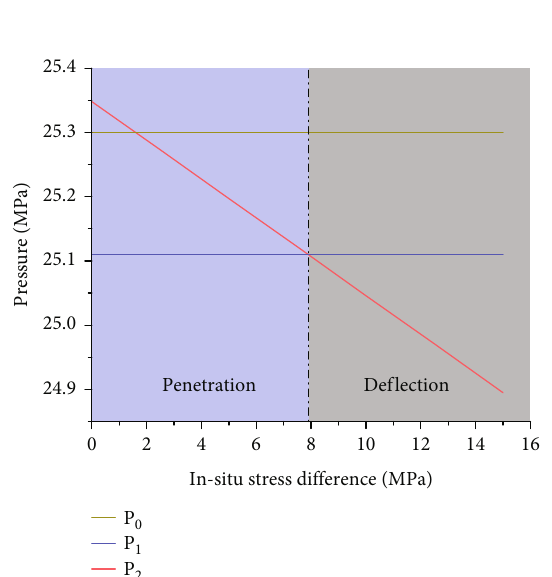
Figure 3: Changes in P di ff erences.